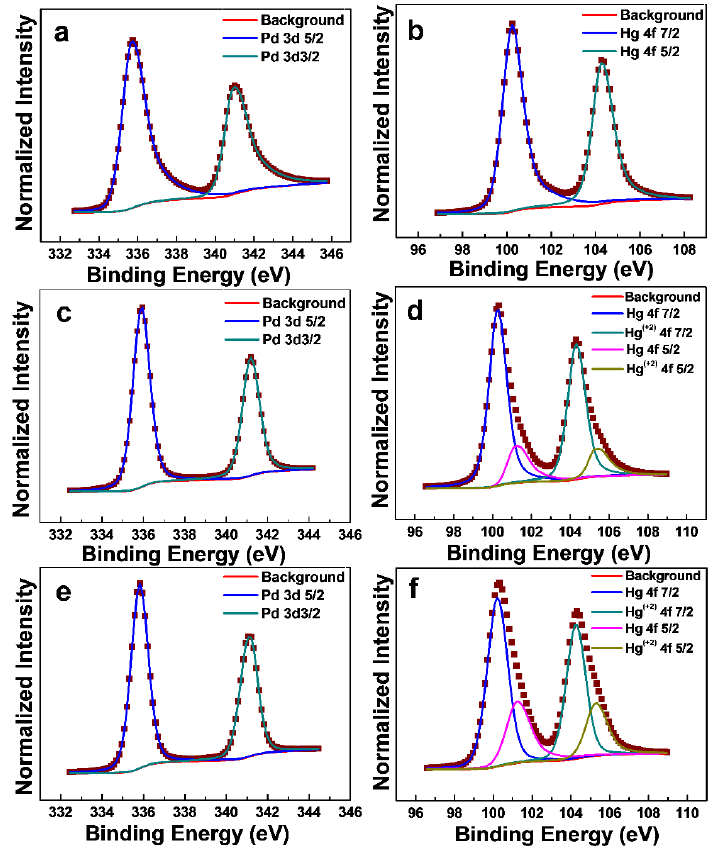
Figure 6. XPS analysis of prepared samples ( a ) PdHg100 Pd 3d, ( b ) PdHg100Hg 4f, ( c ) PdHg200 Pd 3d, ( d ) PdHg200 Hg 4f, ( e ) PdHg800 Pd 3d and ( f ) PdHg800 Hg 4f.